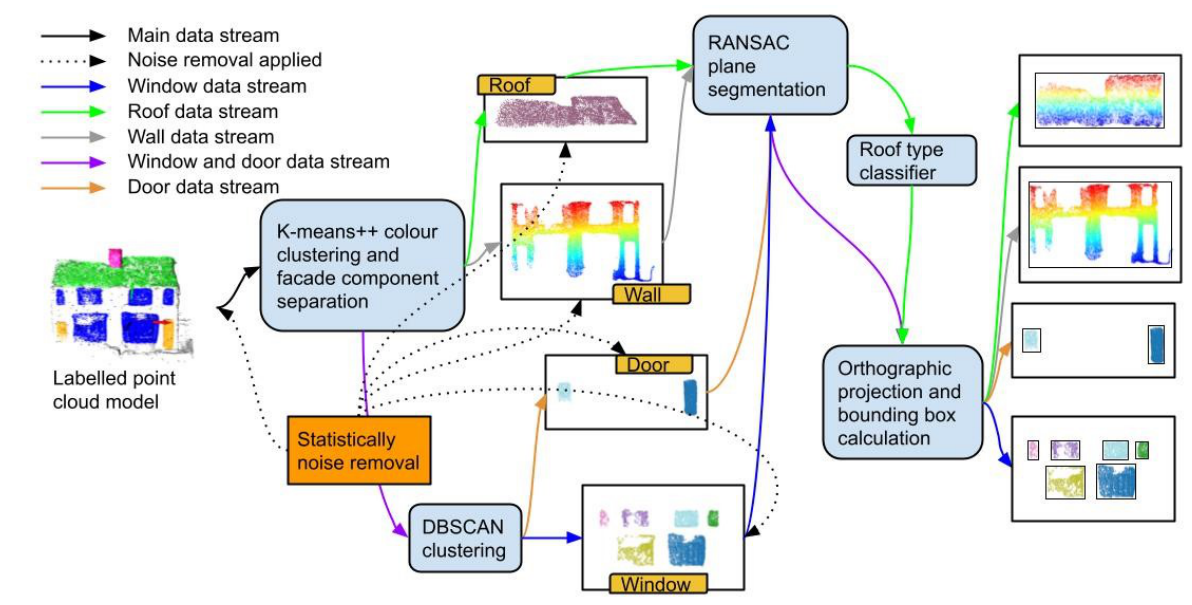
Figure 6. The scope and simple demonstration of the developed building measurement pipeline. The pipeline starts from the annotated point cloud model, which is achieved by texturing semantic masks to the colourless model. As texturing will lose colour uniformity, the K-means++ is first adopted to cluster points with similar colours. Then for larger objects, the RANSAC algorithm is applied to detect planes and then uses bounding boxes to measure their dimensions. For smaller objects, DBSCAN is used to separate individual objects. Prior to applying every algorithm, statistical noise removal is applied to clean the